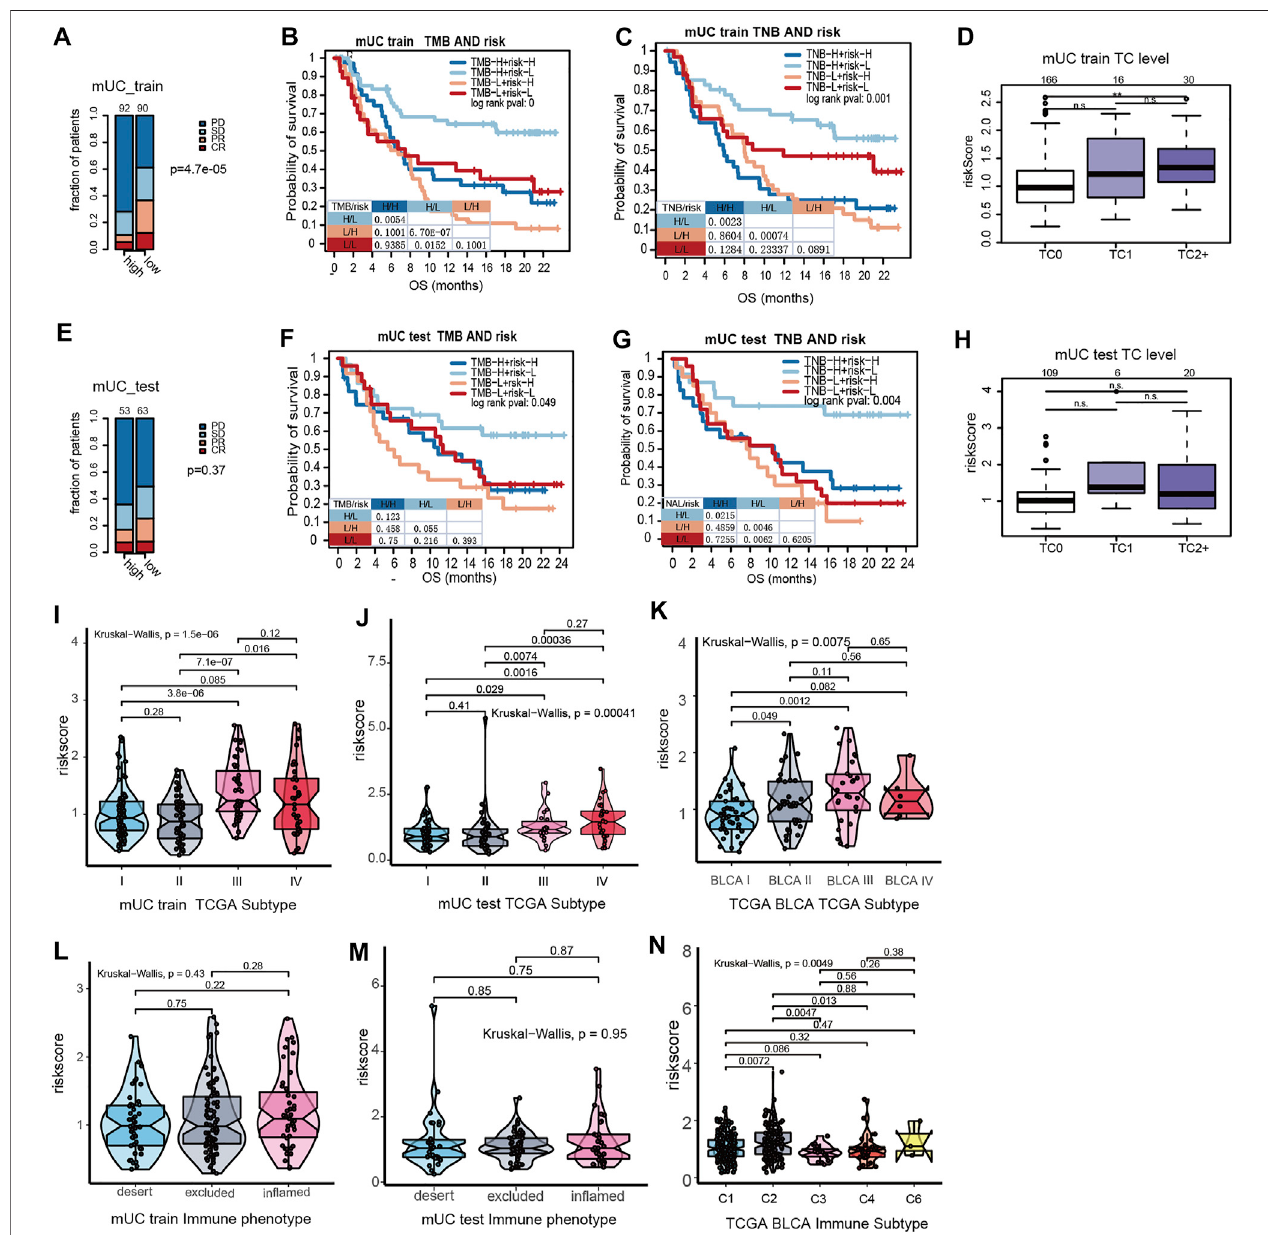
FIGURE 3 | The interations of clinical features in MUC and hypoxia risk score. (A) The stacked histogram showed that the number of non-responders to ICI in the MUC Training set high risk score subgroup was higher than that in the low score subgroup. (B,C) Kaplan Meier curve showed the survival results of the joint analysis of MUC Training set risk score with TMB and TNB. (D) Box plot showed that the PD-L1 expression in tumor cells of the MUC training set. PD-L1 was higher in tumor cells withhigh hypoxia riskscore. (E) Histogramshowed thatthe number ofnon-responderstoICI in theMUC testing set high riskscoresubgroup washigher than that in the low score subgroup. (F,G) KM curve showed the survival results of risk score combined with TMB and TNB in the MUC testing set. (H) Box plot showed the expression of risk score and PD-L1 in tumor cells of the MUC testing set. There was no signi fi cant difference in the expression level of risk score among different PD-L1 expression levels. (I – K) Violin diagram shows the distribution ofMUC training set, MUC testing set and TCGA BLCA risk score in TCGA molecular subtypes. The results showed that the risk score of TCGA III was higher than that of other types. The distribution of the MUC training set, MUC testing set and TCGA BLCA risk score in immunophenotyping was shown by violin